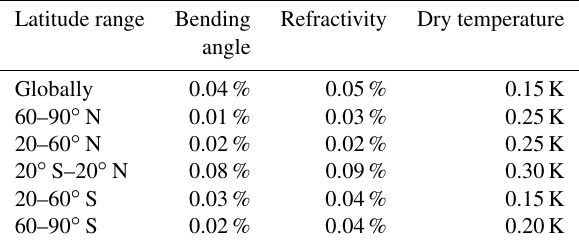
Table 2. RO mission consistency above 8km and below 30km. Consistency is here defined as the largest time-averaged difference between any two RO satellite